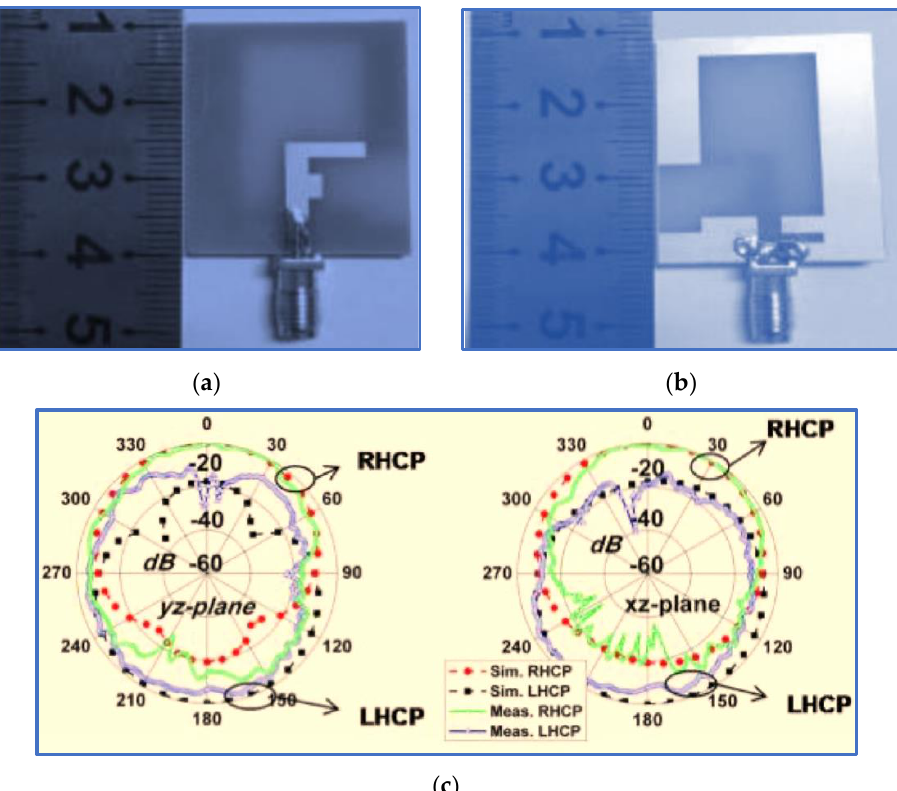
Figure 14. Fabricated prototype: ( a ) front view, ( b ) back view, and ( c ) simulated and measured radiation patterns at 3 GHz [91].